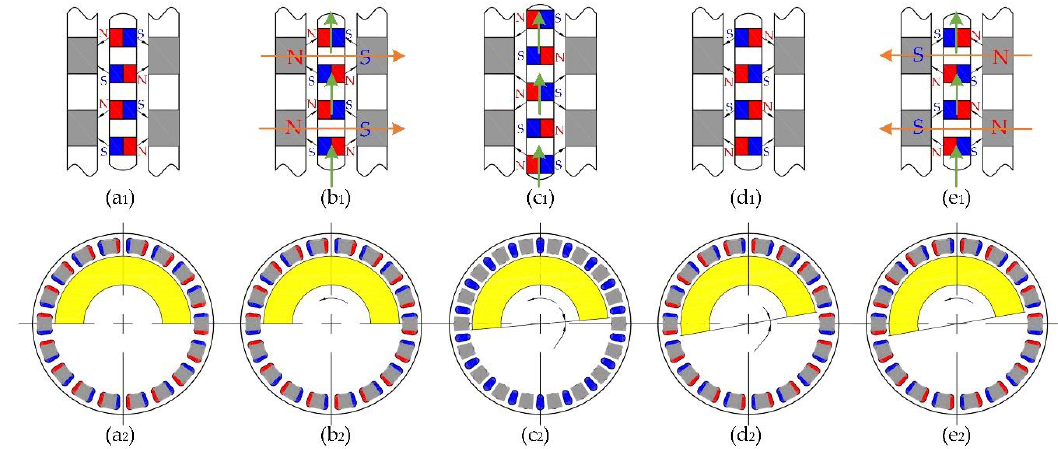
Figure 5. Step rotary process of the balancing actuator: ( a ) Self-lock condition; ( b ) Start-up of step rotation; ( c ) Middle of step rotation; ( d ) End of step rotation; ( e ) Start-up of next step.